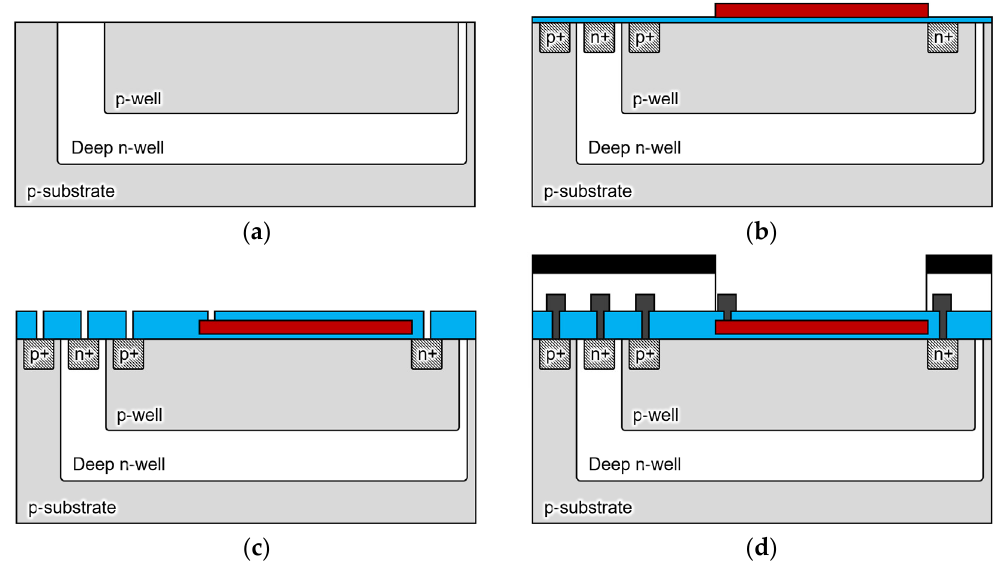
Figure 4. Cross-sectional schematic of the sensor fabrication process. ( a ) A p-type 4-in silicon wafer (60 Ω /cm) is ion-implanted and driven in under the conditions that are shown in Table 1 to form a double-diffusion well structure; ( b ) the gate oxide film of 60 nm and Poly-Si of 350 nm are deposited, and the gate electrode is formed by phosphorous diffusion; ( c ) 400-nm-thick Tetra ethoxy silane (TEOS) is deposited by low-pressure chemical vapor deposition (LP-CVD), and contact holes are opened by oxide film etching; ( d ) after Al wiring, a light shielding film is formed by Al sputtering of 1.0 μ m outside the sensing area.